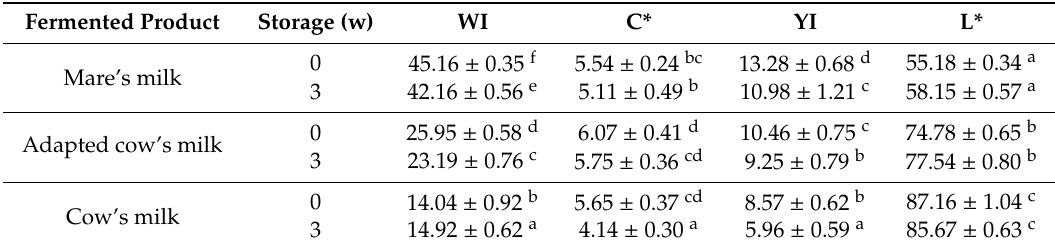
Table 4. Assessment of the color of fermented mare’s milk, fermented cow’s milk adapted to mare’s milk composition and fermented cow’s milk.